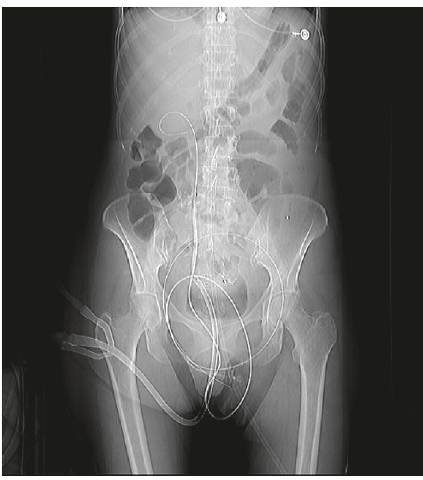
Figure 1: X-ray: probe with endoureteral balloon in place in the right ureter at the level of the fistula with the right primitive iliac artery.